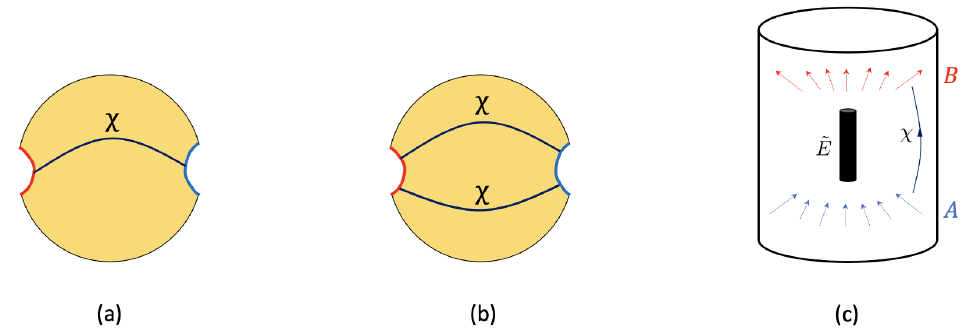
Figure 7 . (a) Correction due to the exchange of a single charge neutral particle χ . (b) Correction due to a two particle exchange process. (c) A cartoon of the process that is captured by